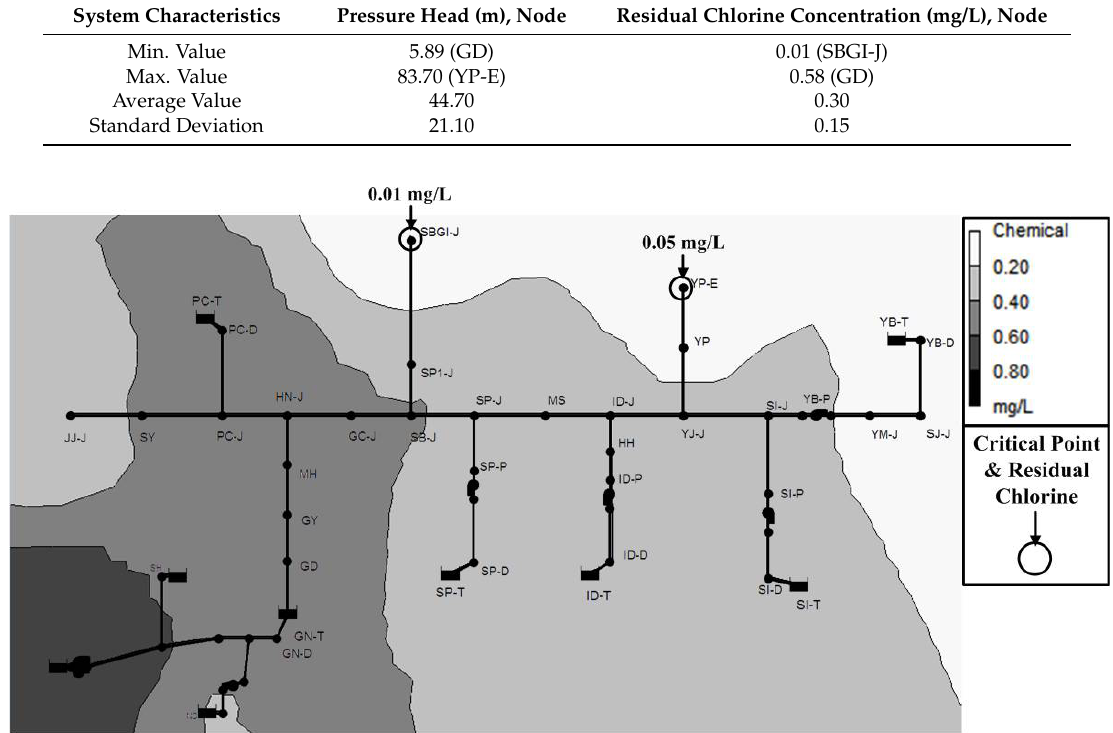
Figure 2. Spatial distribution of residual chlorine for future conditions (P-City).